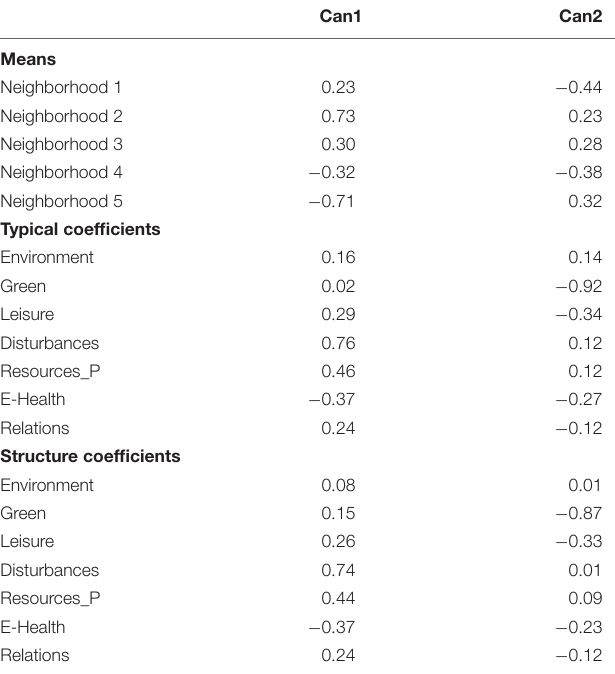
TABLE 2 | Manova results on perception factors by neighborhood.